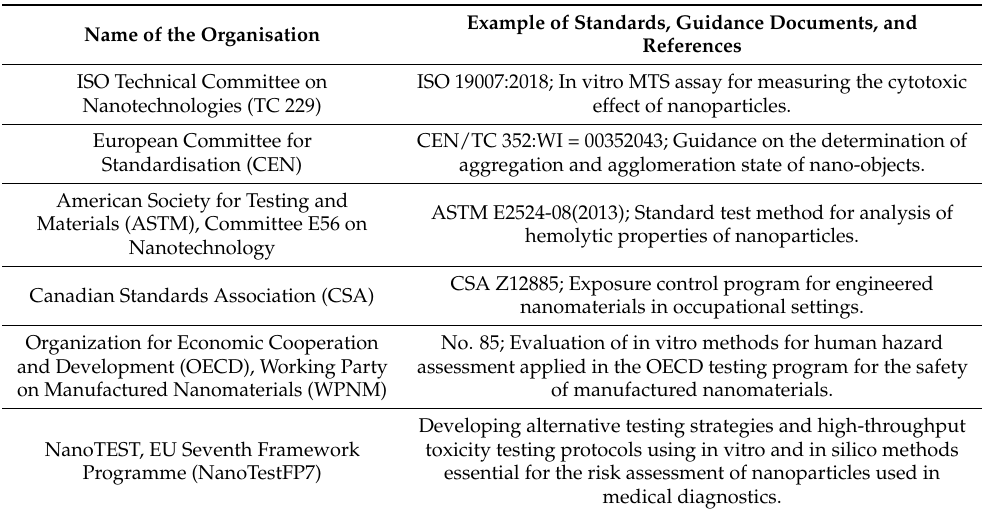
Table 4. Standards Developing Organizations (SDOs) and examples of specific standards and guidelines for nanomaterials characterisations